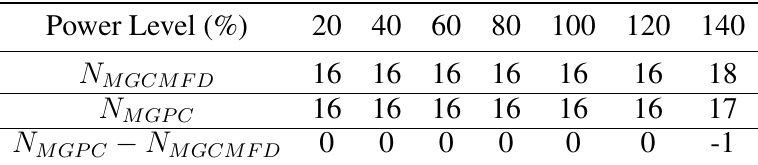
Table 1: Total Number of Outer Iterations for 3D Problem 1